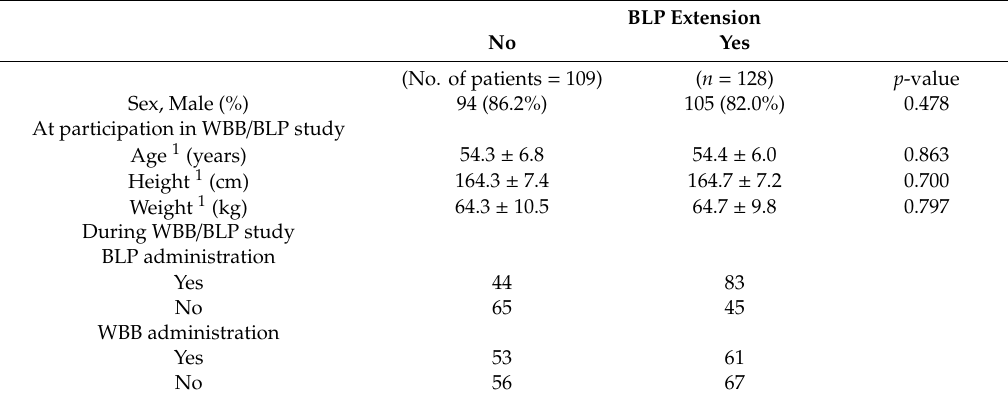
Table 1. Baseline characteristics of patients who consented to